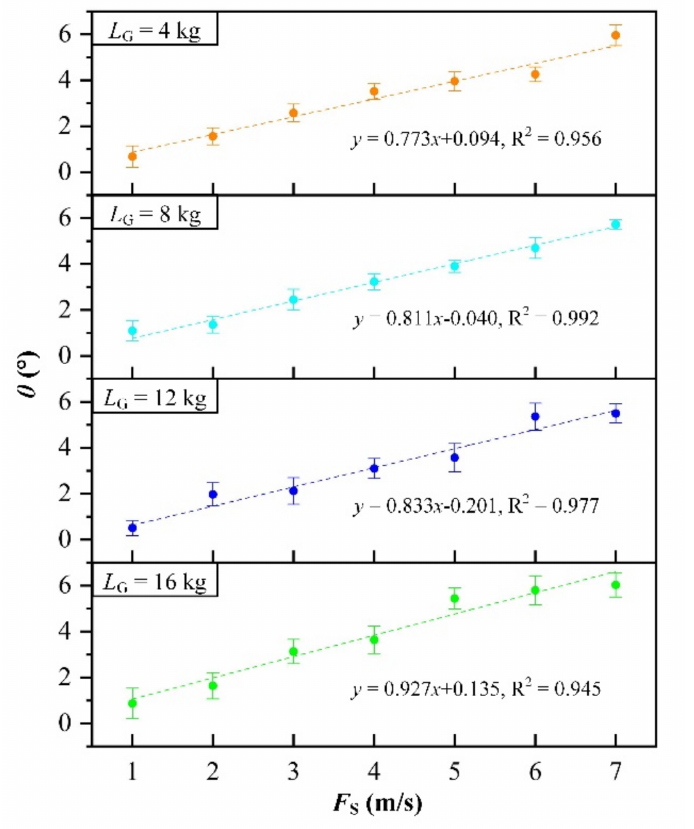
Figure 11. Mean values of measured pitch angle in forwarding flight of the UAV sprayer ( F A = 3 m). The mean ± standard deviation of the pitch angle and the results of linear regression are presented at each treatment with different loads ( L G = 4, 8, 12, and 16 kg) and flight speeds ( F S = 1 − 7 m s − 1